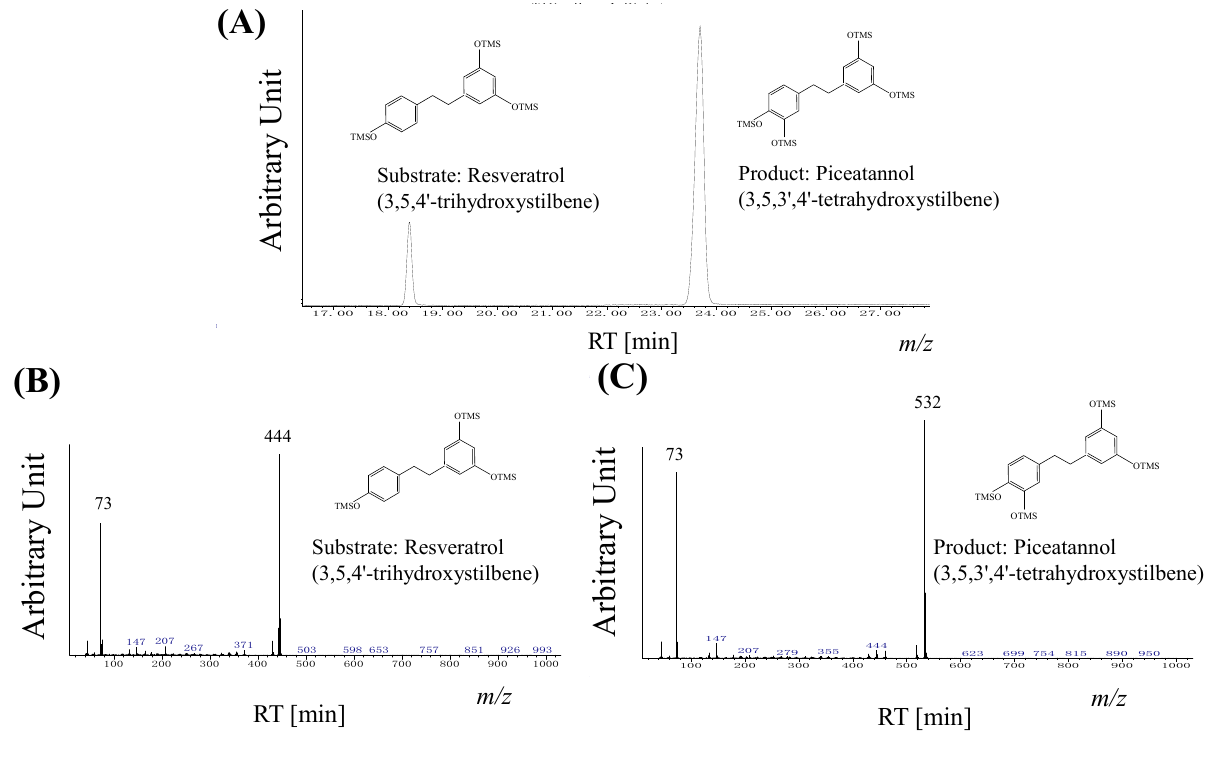
Figure 3. Gas Chromatography-Mass Spectrometry (GC-MS) analysis of resveratrol and piceatannol produced by Streptomyces sp. Strain SB-14. ( A ) GC chromatograms of resveratrol and piceatannol, Retention times: resveratrol, 18.4 min; piceatannol, 23.7 min ( B ) Mass spectra of resveratrol ( C ) Mass spectra of